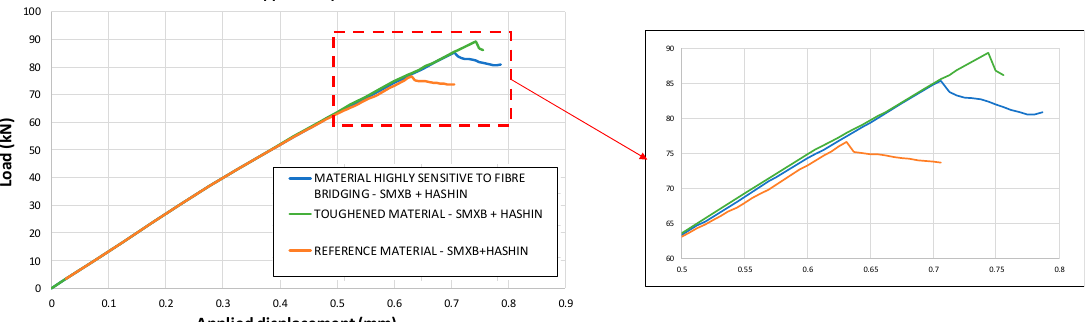
Figure 7. Load vs. Applied displacement (SMXB).